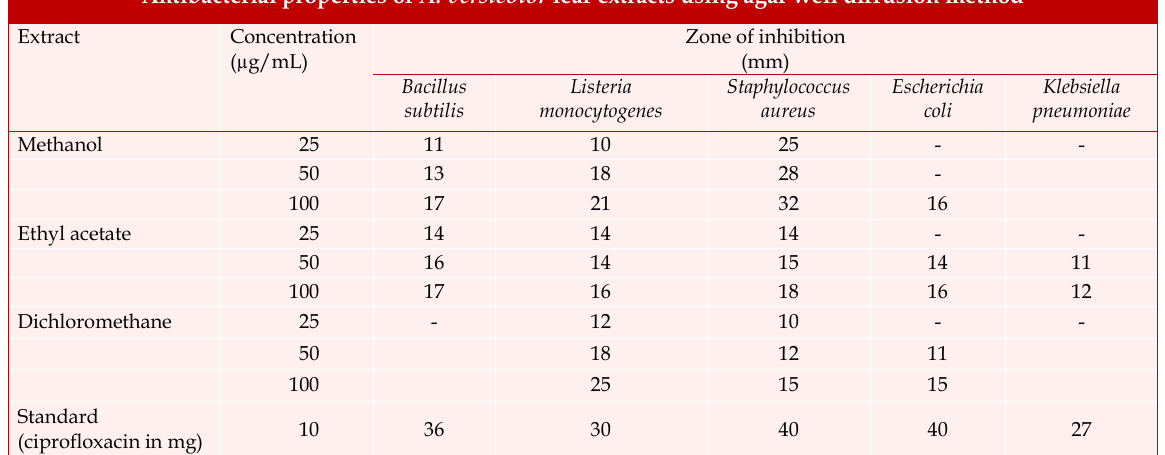
Antibacterial properties of A. versicolor leaf extracts using agar well diffusion method Extract Concentration Zone of inhibition (µg/mL) (mm) Bacillus Listeria Staphylococcus subtilis monocytogenes aureus